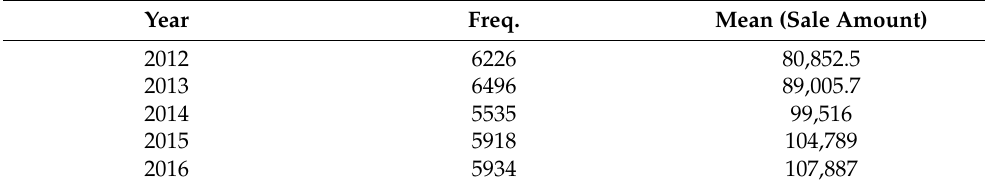
Table 3. The average value of house prices gradually increases with the number of years away from the year of purchase.